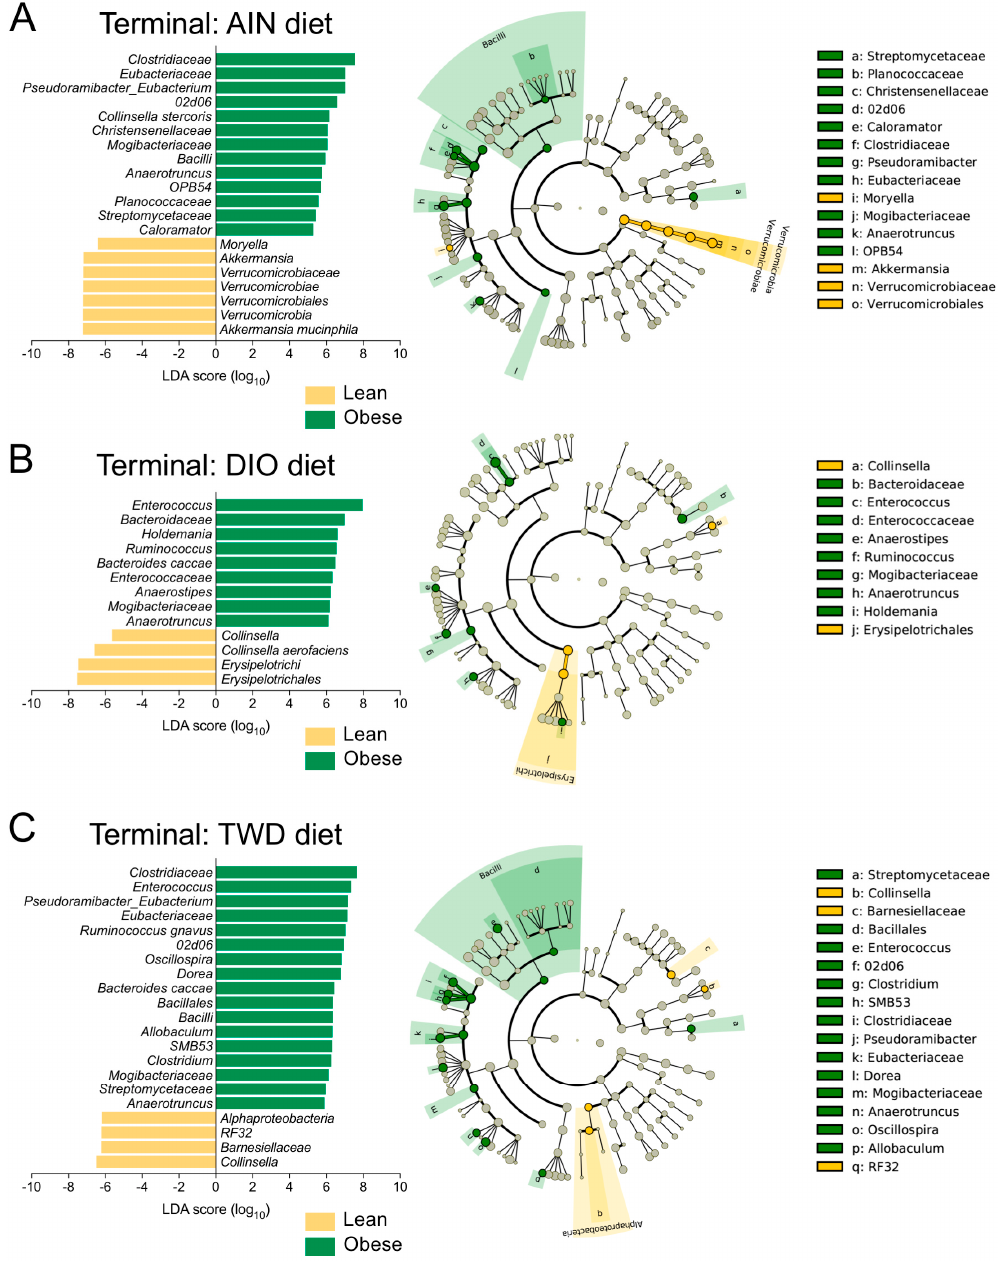
Figure 7. Taxa that discriminated between lean and obese human donors in recipient mice at necropsy. LEfSe analyses were performed using relative abundance data averaged by human donor at the highest classification level taxonomy available. Data shown are the log 10 linear discriminant analysis (LDA) scores following LEfSe analyses and the hierarch of discriminating taxa visualized as cladograms for class comparisons between lean human donors and obese human donors in recipient mice fed ( A ) AIN, ( B ) DIO, or ( C ) TWD diets. Relative abundance data of selected taxa of interest are shown in Figure S10.